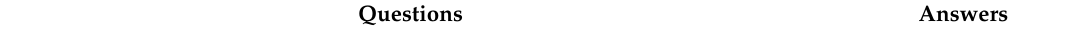
Table A3. Summary of questions in the “general thermal comfort of experienced thermal environments”